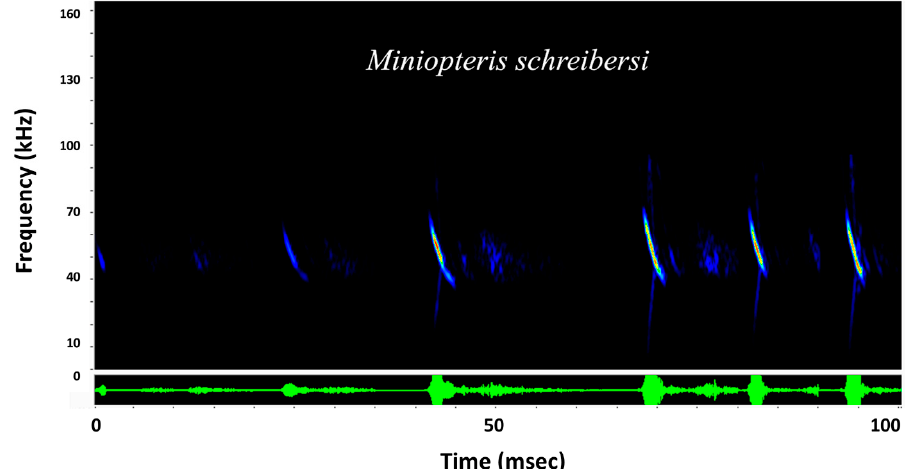
Figure 4. Representative sonogram for Miniopteris schreibersii (family Miniopteridae) presented using Sonobat 4.1. Y -axis is frequency in kilohertz (kHz) and x -axis is time standardized over 100 milliseconds (msec). Blue coloration indicates lowest sound intensity of the call, yellow indicates medium intensity, and red indicates highest intensity or loudest portion of the call. Green display represents an oscillogram of the call sequence.